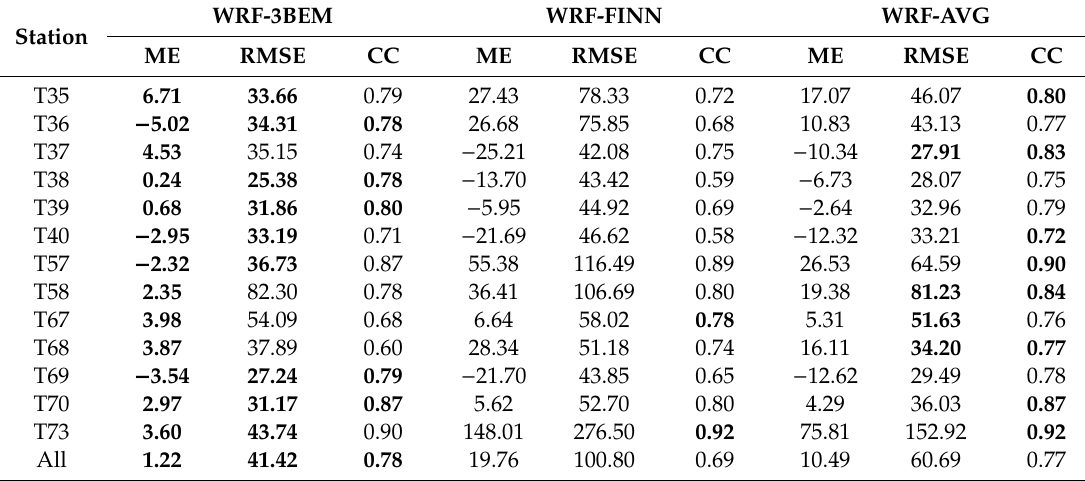
Table 7. MEs (E[simulations-measurements]), RMSEs, and CCs of simulations and measurements